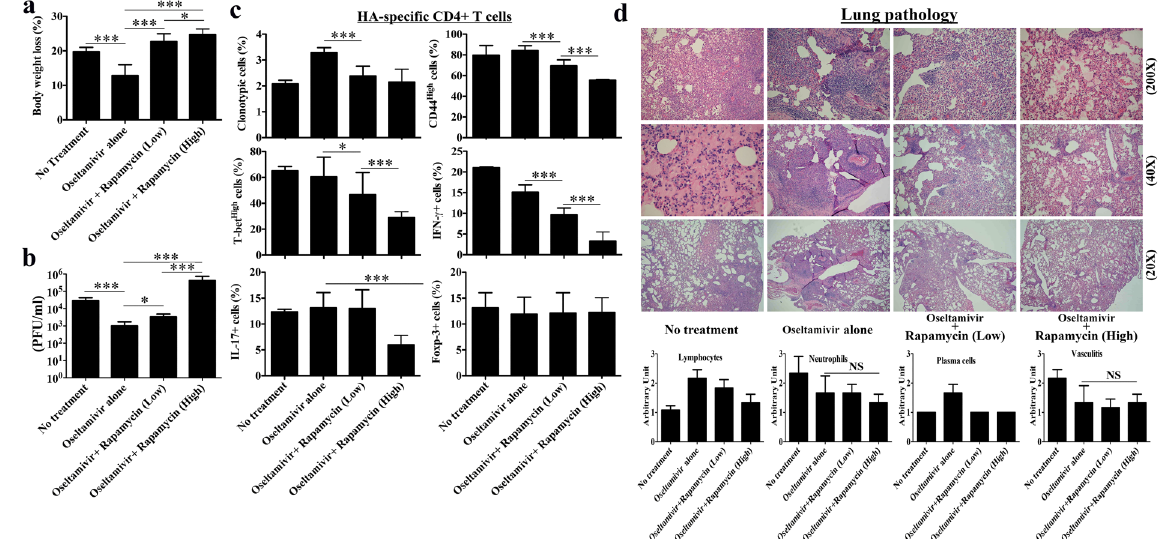
Figure 5. Rapamycin salvage impairs virus clearance with suppressed antigen-specific T cell immunity and aggravates overall lung inflammation with severe intra-alveolar edema and hyaline deposition. Naïve BALB/c mice of comparable age received adoptive transfer of 2.5 × 10 6 naïve HA-specific 6.5 CD4 + T cells with infection of 2.5 × 10 3 PFU PR8 virus. Rapamycin and Oseltamivir treatment was started from day 2- post infection and control untreated mice received daily intraperitoneal injection of equal volume placebo solvent and oral feeding of phosphate buffered solution (PBS). Mice with Oseltamivir only served as another control group. On day 7- post infection, compared to untreated and Oseltamivir only mice, Rapamycin salvage treatment caused ( a ) more body weight loss in mice with ( b ) impaired virus clearance in the lungs.